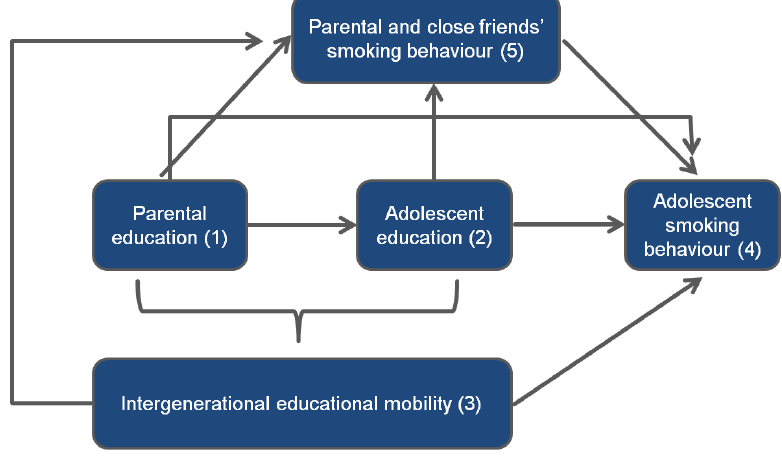
Figure 1. Model of the association between different educational measures and adolescent smoking behaviour allowing for parental and close friends’ smoking